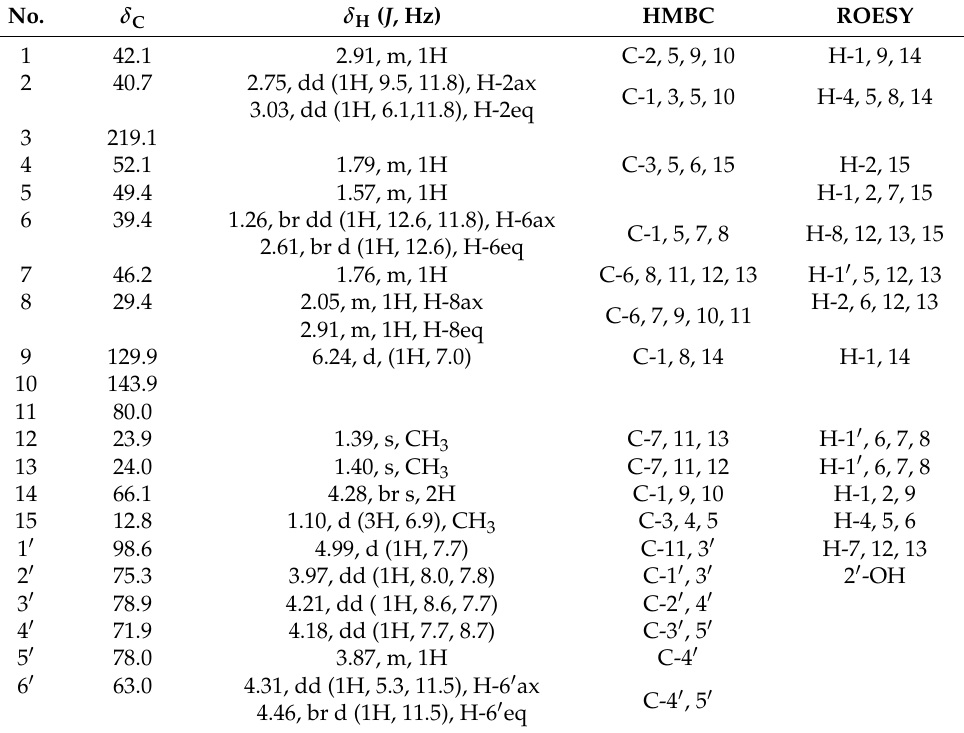
Table 2. The 1 H-NMR (500 MHz), 13 C-NMR (125 MHz), HMBC, and ROESY spectra data for Compound 2 ( δ , TMS, pyridine- d 5